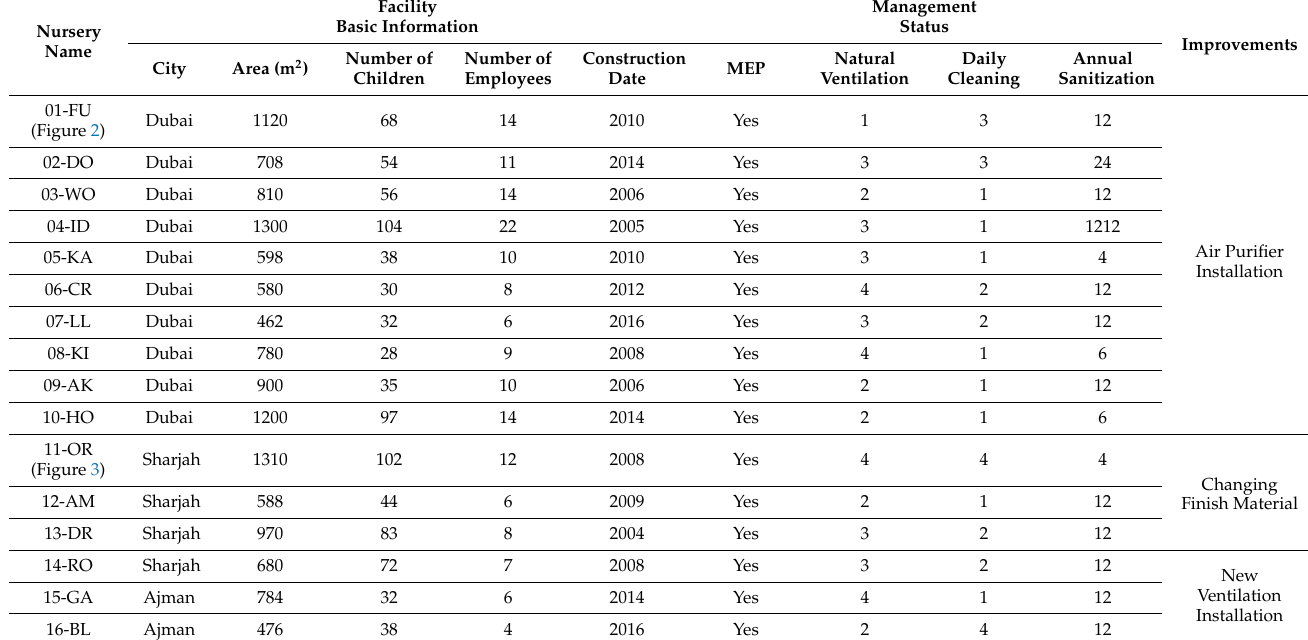
Table 1. 16 Target Nurseries in United Arab